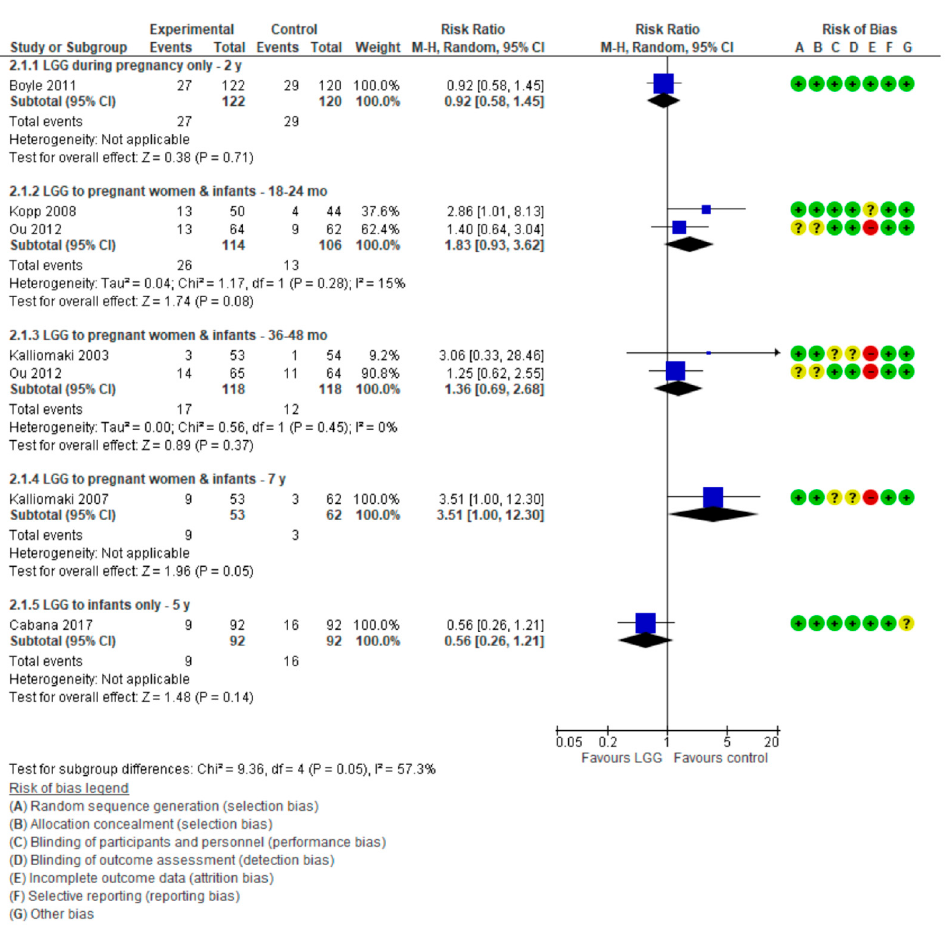
Figure 4. Secondary outcome: Effect of LGG supplementation on wheezing/asthma (data presented based on the timing of LGG administration and the timing of assessment).